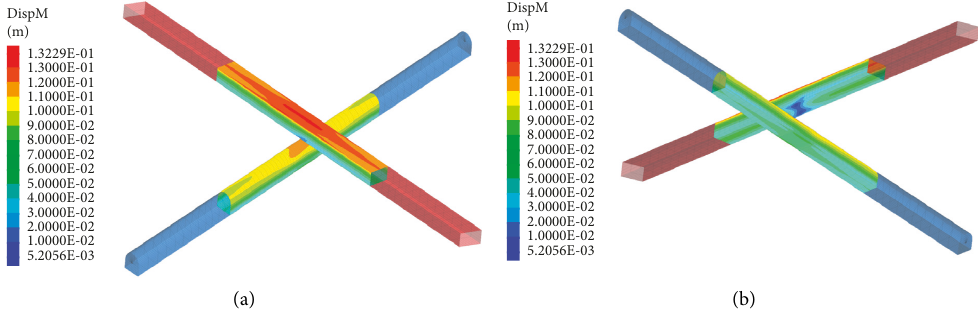
Figure 18: Deformation characteristics of surrounding rock in the staggered roadways position. (a) Vertical view and (b) bottom view.